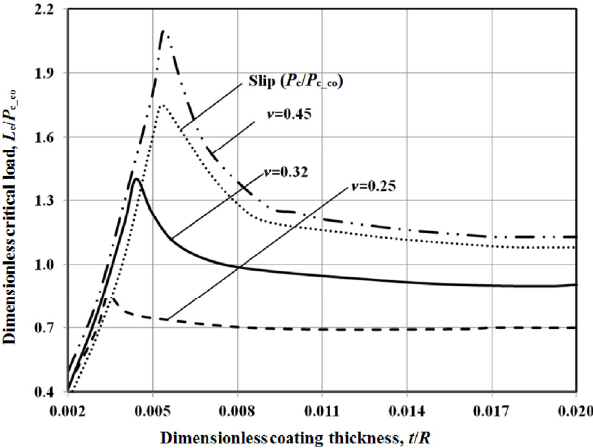
Fig. 6 Dimensionless critical load L c /P c_co vs. dimensionless thickness t / R ( E co /E su = 4 ,  y_su =  y_co =